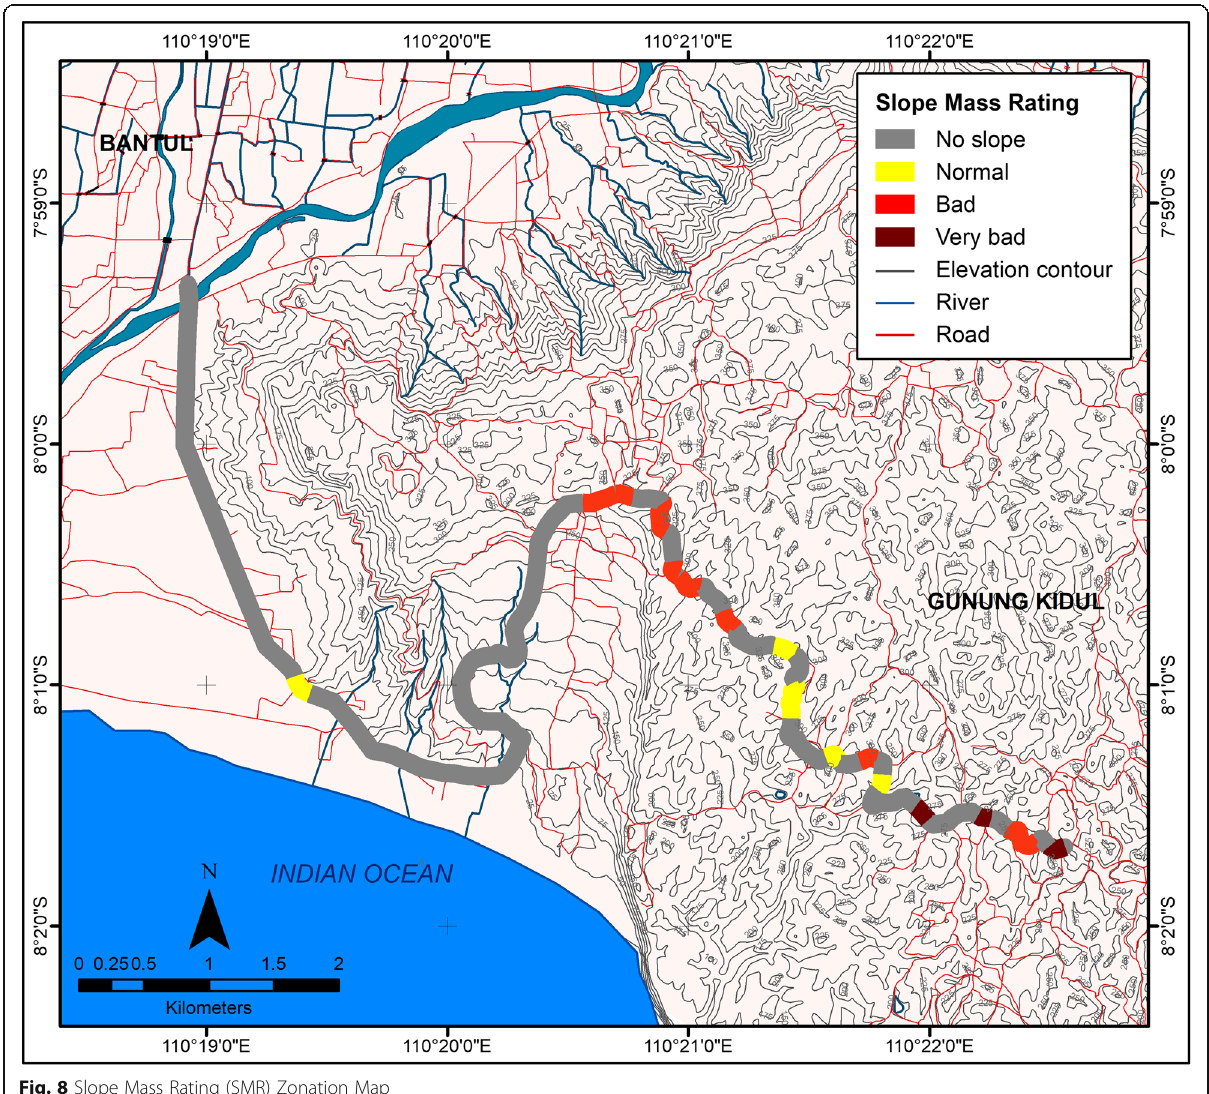
Fig. 8 Slope Mass Rating (SMR) Zonation Map